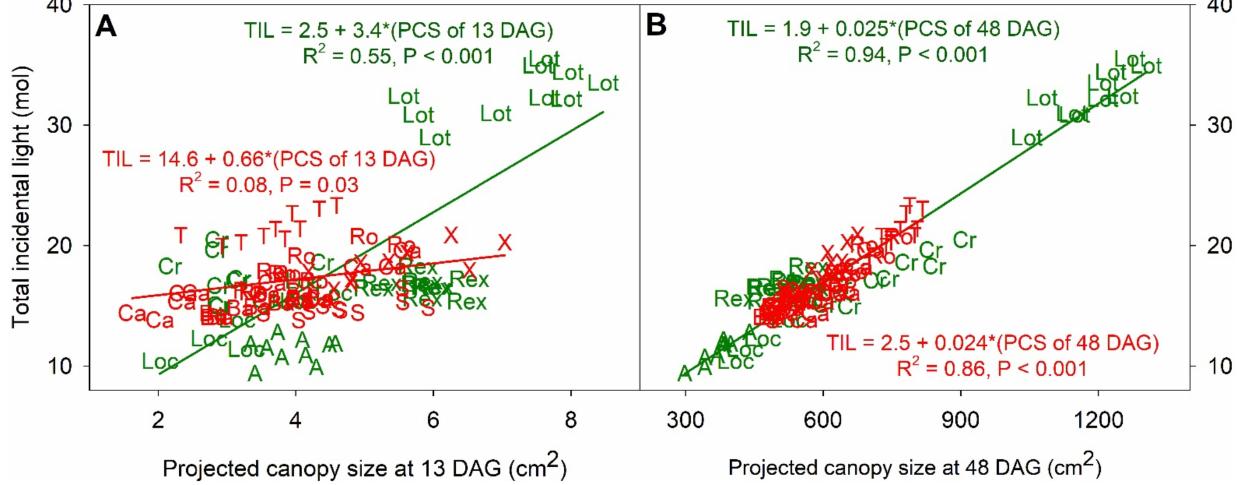
Figure 6. The relation between total incidental light and projected canopy size (PCS) at 13 ( A ) and 48 ( B ) days after germination (DAG). Letters and their colors on the figures correspond to name of cultivars (‘Aquino’ (A), ‘Barlach’ (Ba), ‘Carmessi’ (Ca), ‘Crunchita’ (Cr), ‘Locarno’ (Loc), ‘Lotus’ (Lot), ‘Rex’ (Rex), ‘Rouxai’ (Ro), ‘Seurat’ (S), ‘Teodore’ (T), and ‘Xandra’ (X)) and red and green lettuce cultivars. The regression summaries were labeled adjacent to the regression